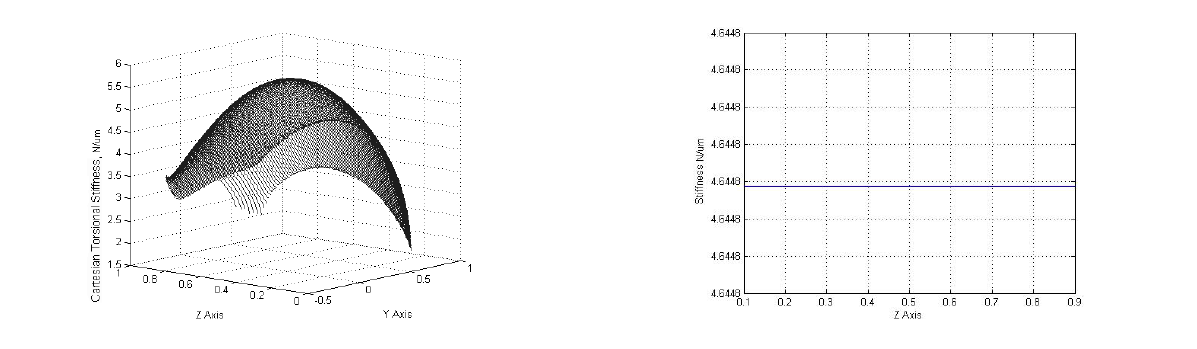
Figure 21: The Cartesian torsional stiffness in the Z- direction as function of the Y- and Z- coordinates.